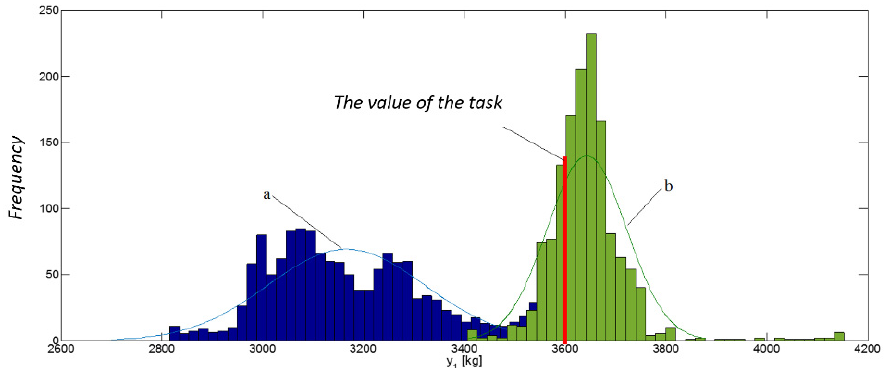
Table 3. Weight of material on the conveyor without and with the control system [22].